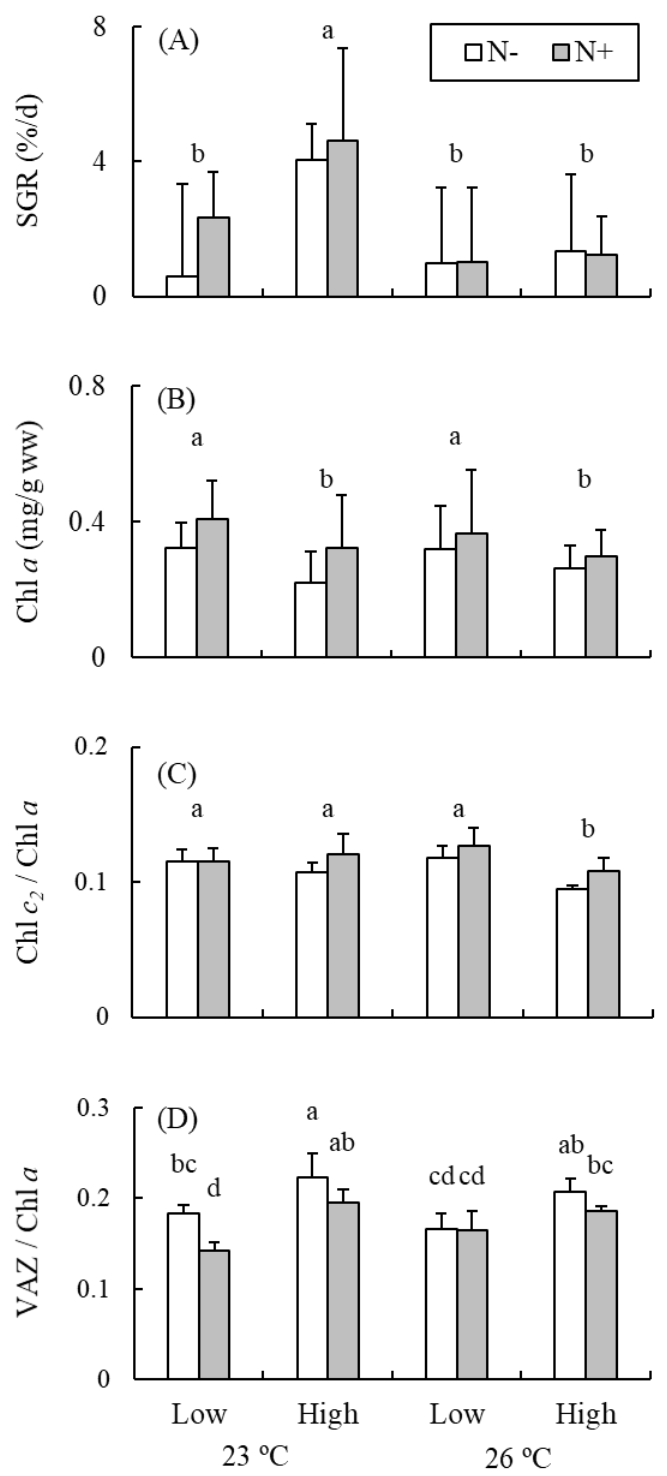
Figure 1. Specific growth rate ( A ), Chl a content ( B ), Chl c 2 / Chl a ratio ( C ), and VAZ/Chl a ratio ( D ) of Sargassum fusiforme shoots cultured in eight different treatments (mean + SD, n = 6). Low and High indicate low (30 μmol photon m −2 s −1 ) and high (150 μmol photon m −2 s −1 ) irradiance treatments, respectively. N+ and N- indicate nutrient enriched and non-enriched treatments, respectively. Different small letters such as a, b, ab, bc, cd, d, bc denote statistical significances among different treatments where P < 0.05.